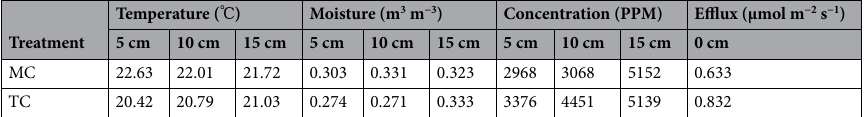
Table 1. The mean value of soil profile temperature, moisture concentration and soil surface CO2 efflux in the TC treatment and MC treatment.